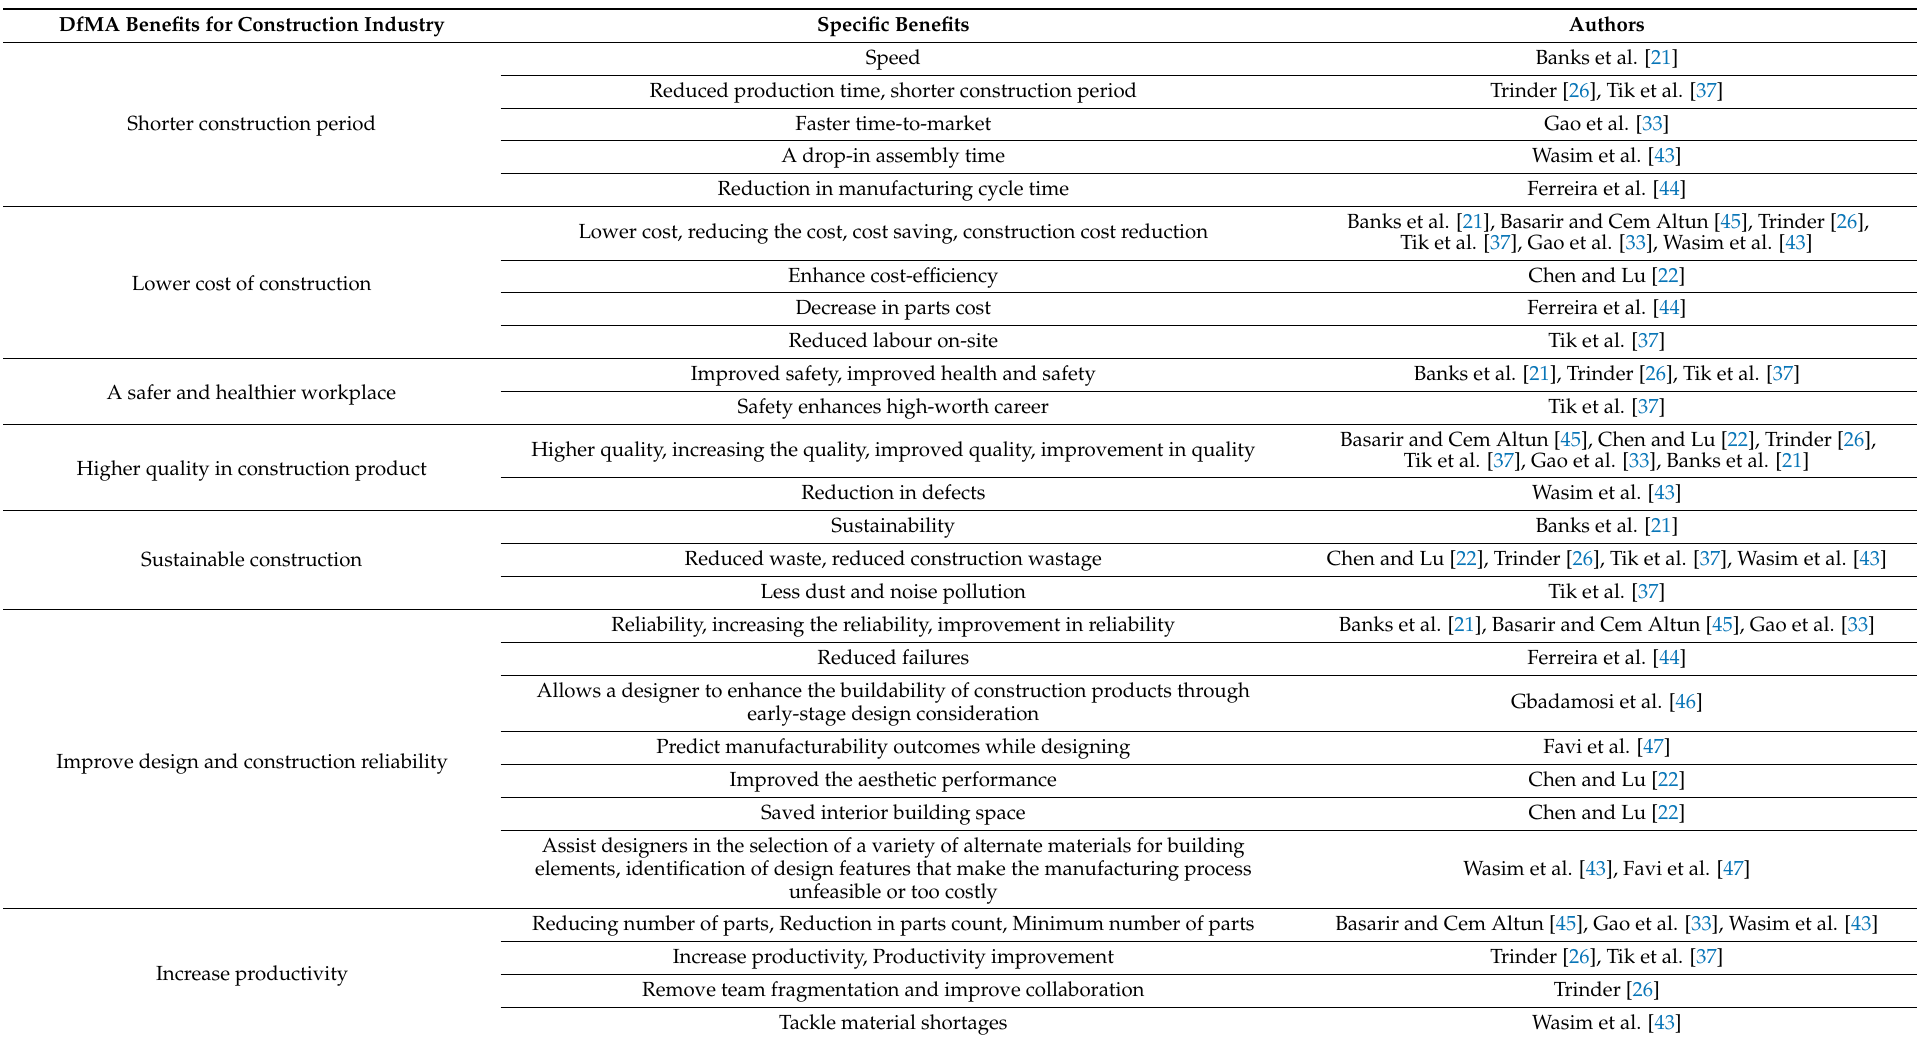
Table 1. The benefits of DfMA in